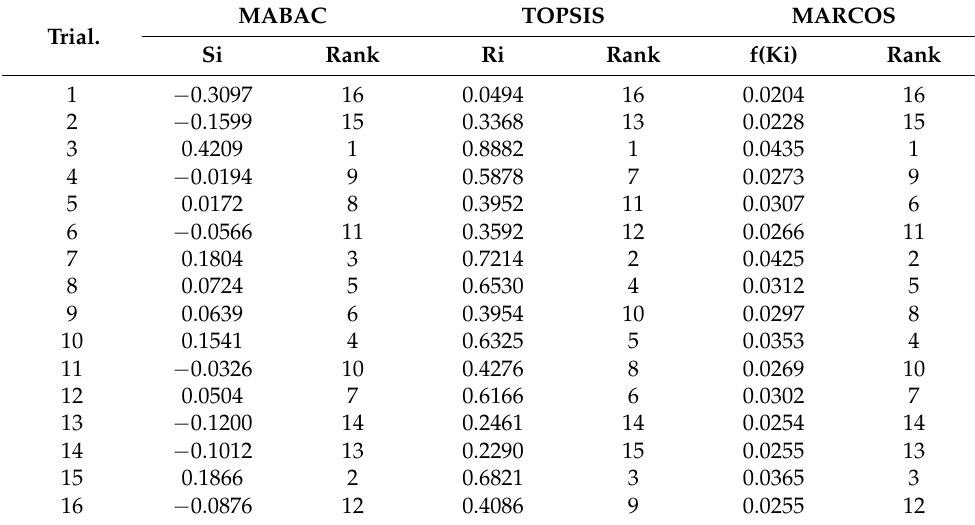
Table 6. Priority index and ranking when the weight calculation by entropy method. Trial.